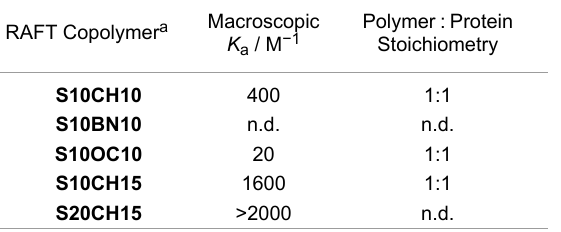
Table 1: UV–vis titrations of cytochrome C with selected RAFT copoly- mers.